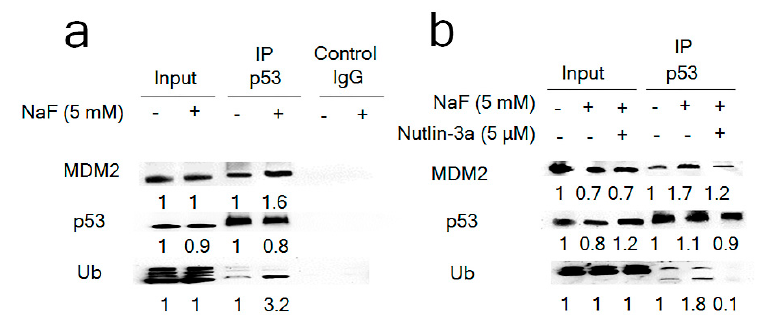
Figure 6. Fluoride induced p53-MDM2 binding and p53 ubiquitination in LS8 cells. LS8 cells were treated with fluoride for 6 h and protein was immunoprecipitated using anti-p53 antibody. p53, MDM2 and ubiquitin were detected by Western blot. ( a ) NaF increased MDM2-p53 binding and increased amounts of ubiquitinated-p53 (Ub-p53). ( b ) MDM2 antagonist Nutlin-3a suppressed fluoride-induced MDM2-p53 binding and decreased Ub-p53 levels. Control IgG was used as a negative control. The numbers show relative protein expression vs. Control (0 mM NaF). Input and Immunoprecipitation (IP) lane relative expression was calculated separately.